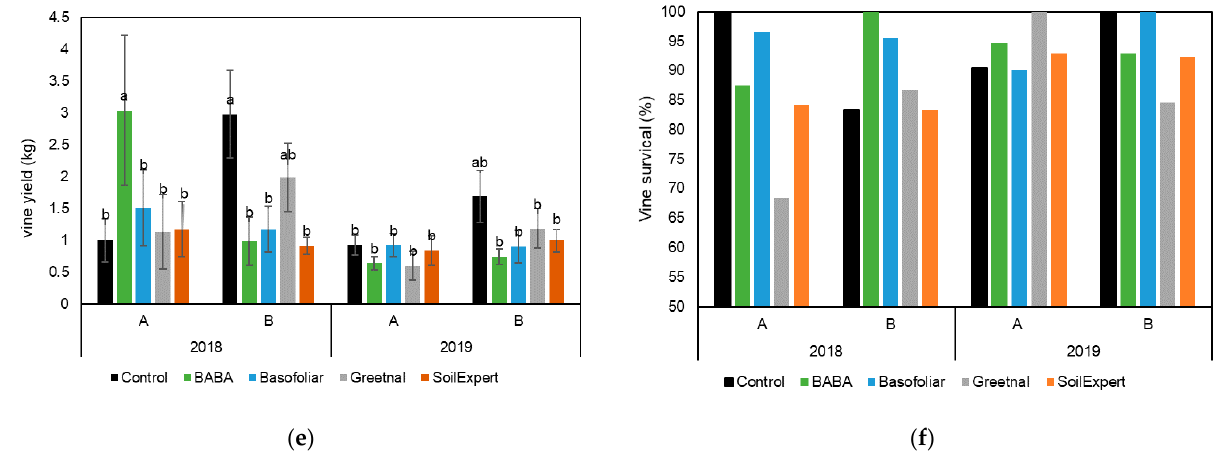
Figure 3. ( a ) Number of clusters per vine; ( b ) cluster weight ( g ); ( c ) cluster length (cm); ( d ) grape diameter (mm); ( e ) vine yield (kg); ( f ) survival (%) in plants of Vitis vinifera var. Tempranillo from two subplots (A and B) sprayed with distilled water (C), BABA, or three commercial biostimulants (Greetnal, Basofoliar, or SoilExpert) in the 2018 or 2019 season. Different letters indicated significant differences according to Duncan’s test after ANOVA.